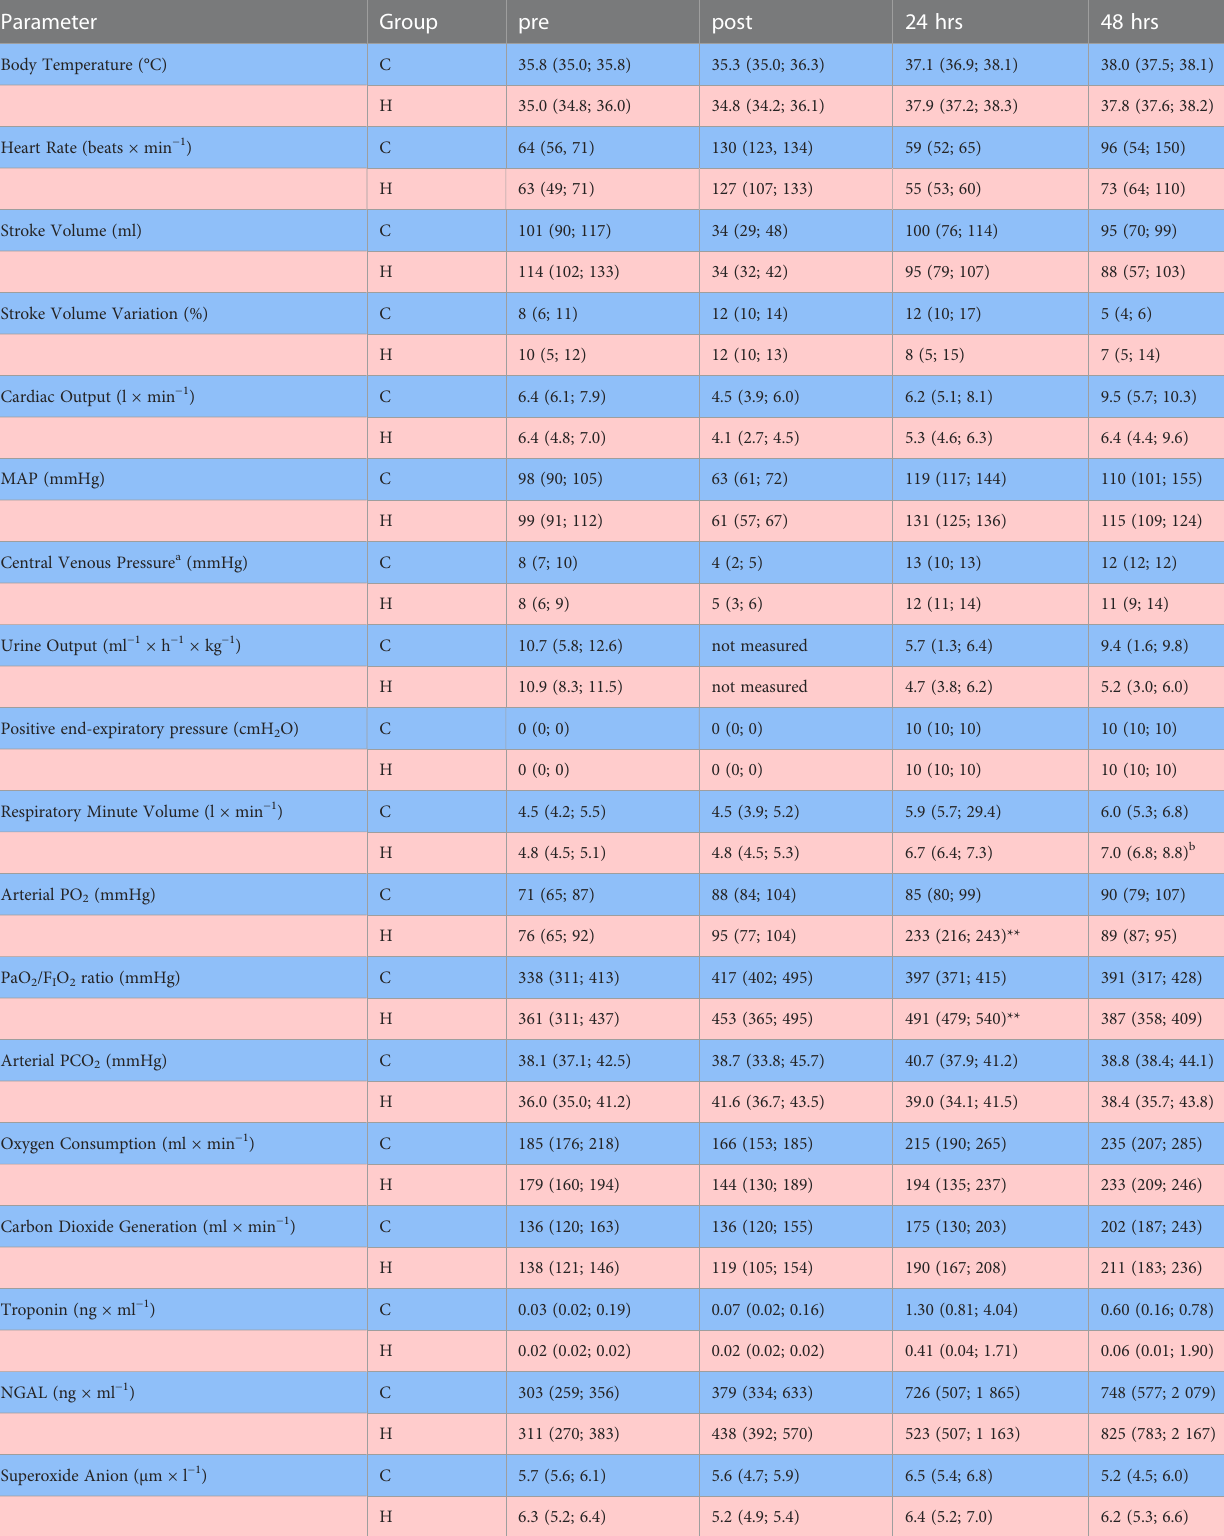
TABLE 1 Organ function parameters for the heart, the lungs, and the kidneys before (pre) and after 2 hrs of hemorrhagic shock and acute subdural hematoma (post) as well as 24 hrs and 48 hrs after